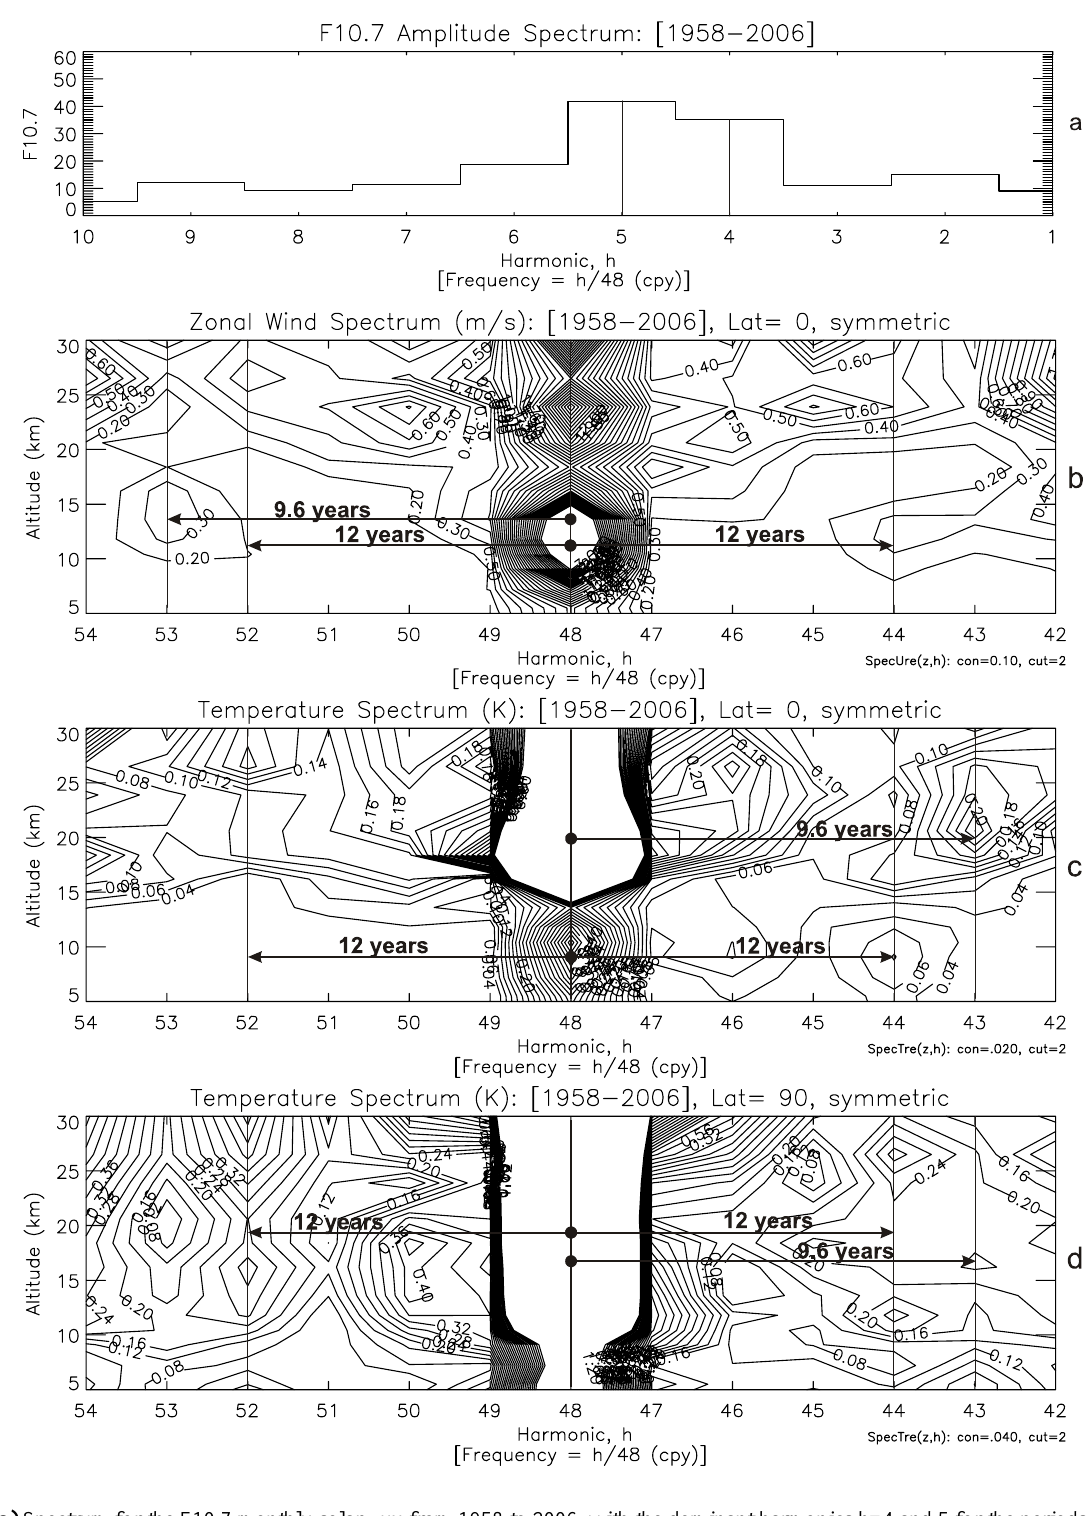
Fig. 6. (a) Spectrum for the F10.7 monthly solar flux from 1958 to 2006, with the dominant harmonics h=4 and 5 for the periods of 12 and 9.6 months, respectively. (b) Symmetric zonal wind spectrum at the equator for the entire 48-years of NCEP/NCAR data. (c, d) Similar to (b), but showing the symmetric temperature spectra at the equator (c) and pole (d). In the spectra, the modulation periods are indicated with arrows, commensurate with the dominant harmonics for the solar flux in